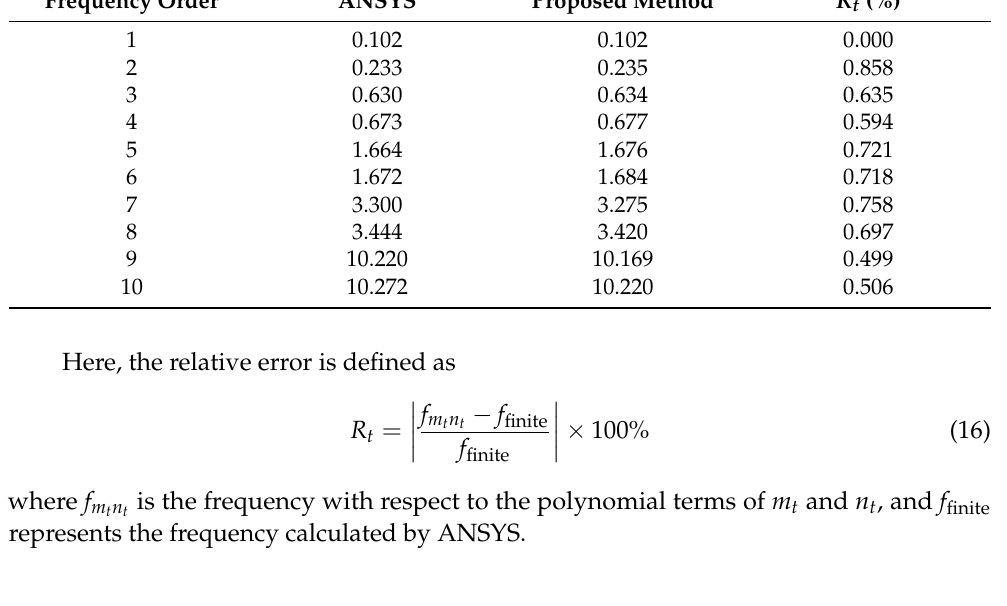
Table 1. Comparison of the first twelve frequencies of the system, f